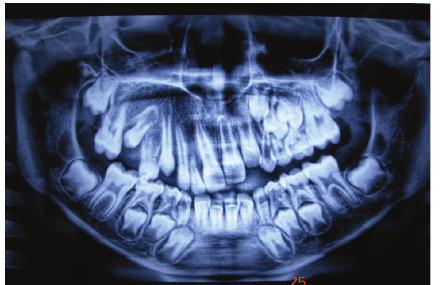
Figure 3: Orthopantamographic view showing the right side osseous enlargement of maxilla with drifting of teeth.